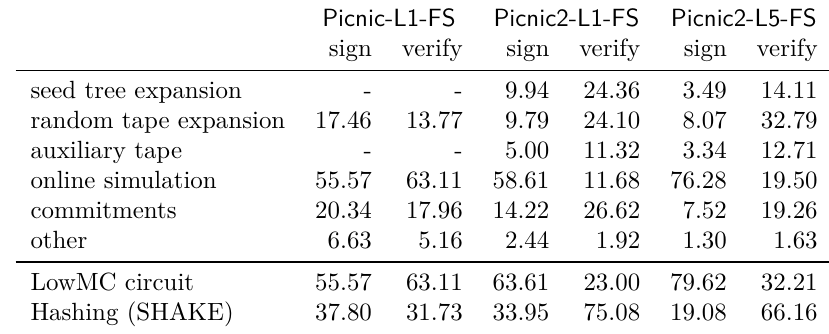
Table 2: Cost breakdown of signing and verification of a subset of Picnic parameter sets (as